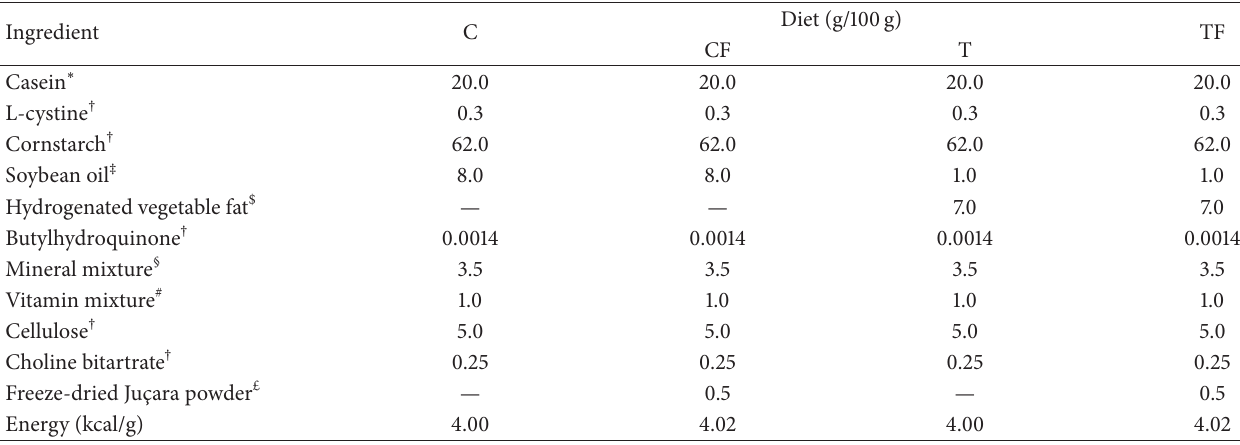
Table 1: Composition of the control diet (C), control diet supplemented with 0.5% freeze-dried Jussara powder (CJ), diet enriched with hydrogenated vegetable fat, TFAs (T), and diet enriched with TFAs supplemented with 0.5% freeze-dried Jussara powder (TJ) according to